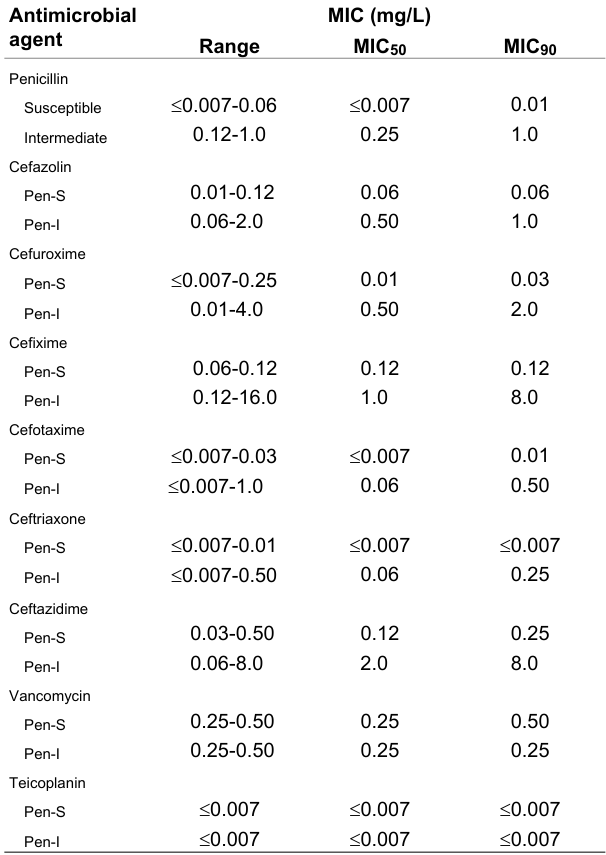
Figueiredo et al (16) us ing a clini cal iso late of S pneu mo niae (se ro type 23F) that had high MIC s to the third- generation cepha lo sporins ce fo taxime and cef tri ax one (2.5 mg/L each). They dis cov ered that this iso late had a pat tern of penicillin- binding pro teins ( PBP ) and a cell wall pep tide com po si tion that were dif fer ent from those of penicillin- resistant pneu mo cocci that were still sus cep ti ble to third- generation cepha lo sporins. cepha lo sporin re sis tance in volved only al tera tions of